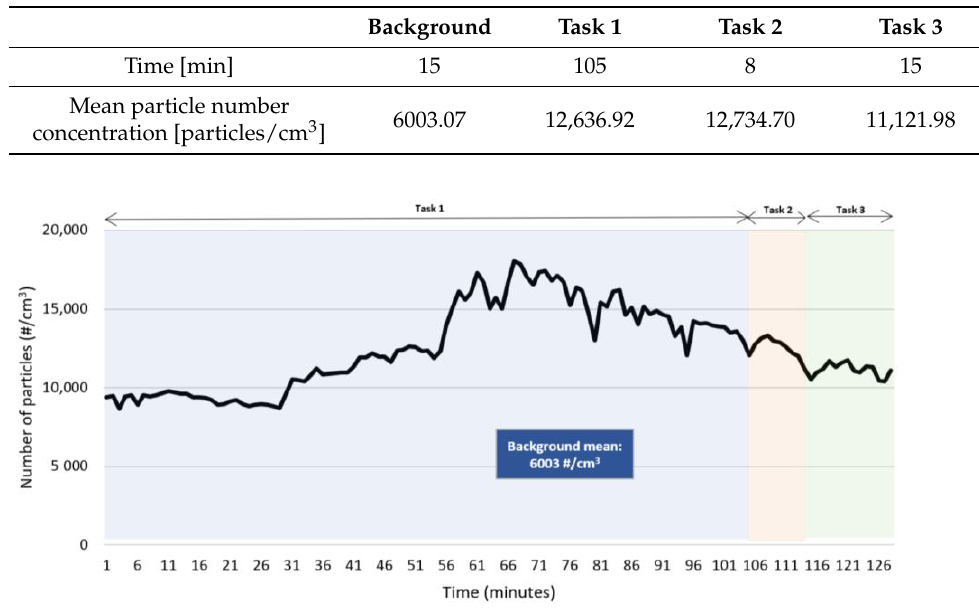
Figure 1. Number particle concentration (#/cm 3 ) over time measured by the CPC.